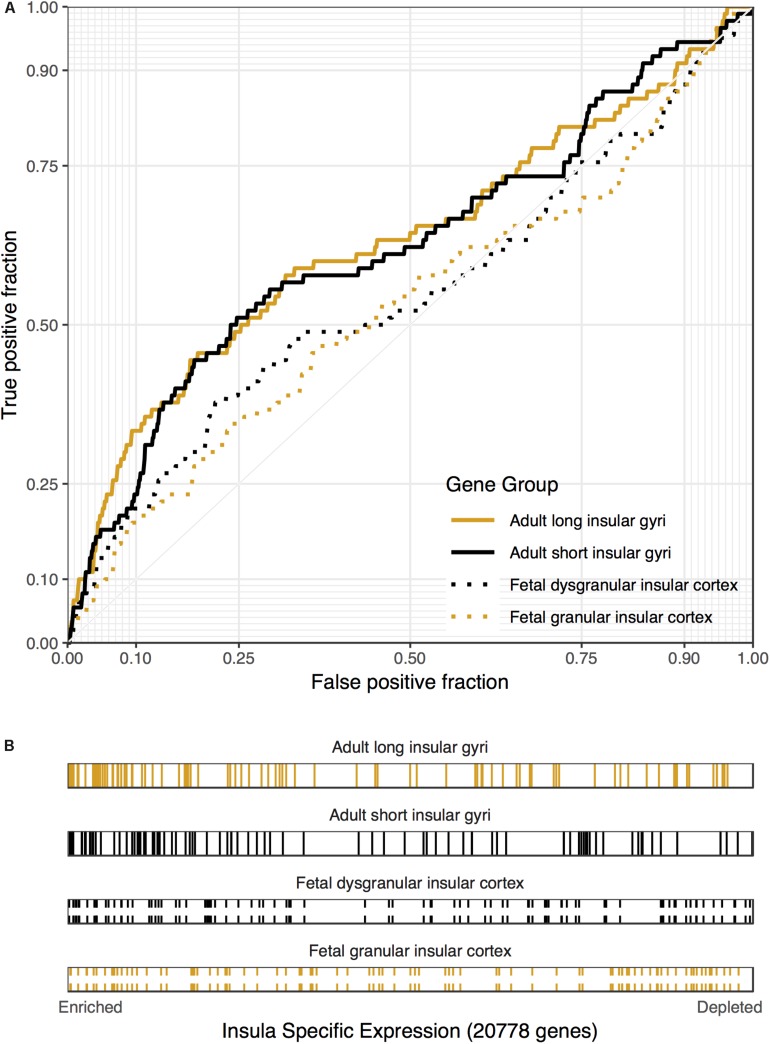
Associations between cocaine-related disorder genes and insular specific expression. (A) ROC curves showing the proportion of cocaine-related disorder genes that overlap (y-axis, true positive fraction) in varying lengths of the insular specific gene rankings (approximated by the x-axis, false positive fraction). (B) Distributions of the cocaine-related disorder genes across the insular specific gene rankings with each gene representing a single colored line. Color marks the short/dysgranular (black) and long/granular (orange) rankings. Dashed lines are used for the fetal datasets.